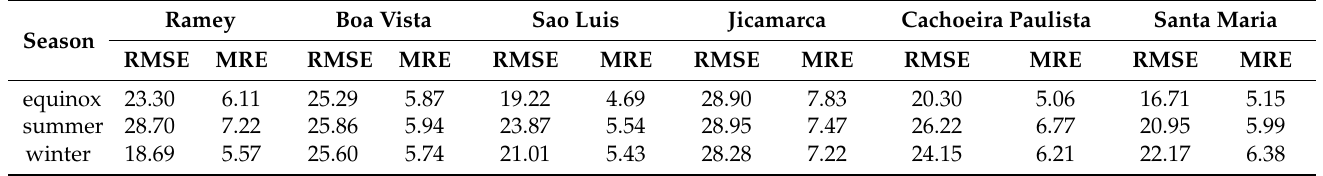
Table A4. Statistics of the differences in h m F 2 obtained from the COSMIC-2 and ionosonde (as the reference) at the six ionosondes under quiet geomagnetic conditions in terms of RMSE (km) and mean |RelE| (MRE, %) in different seasons.